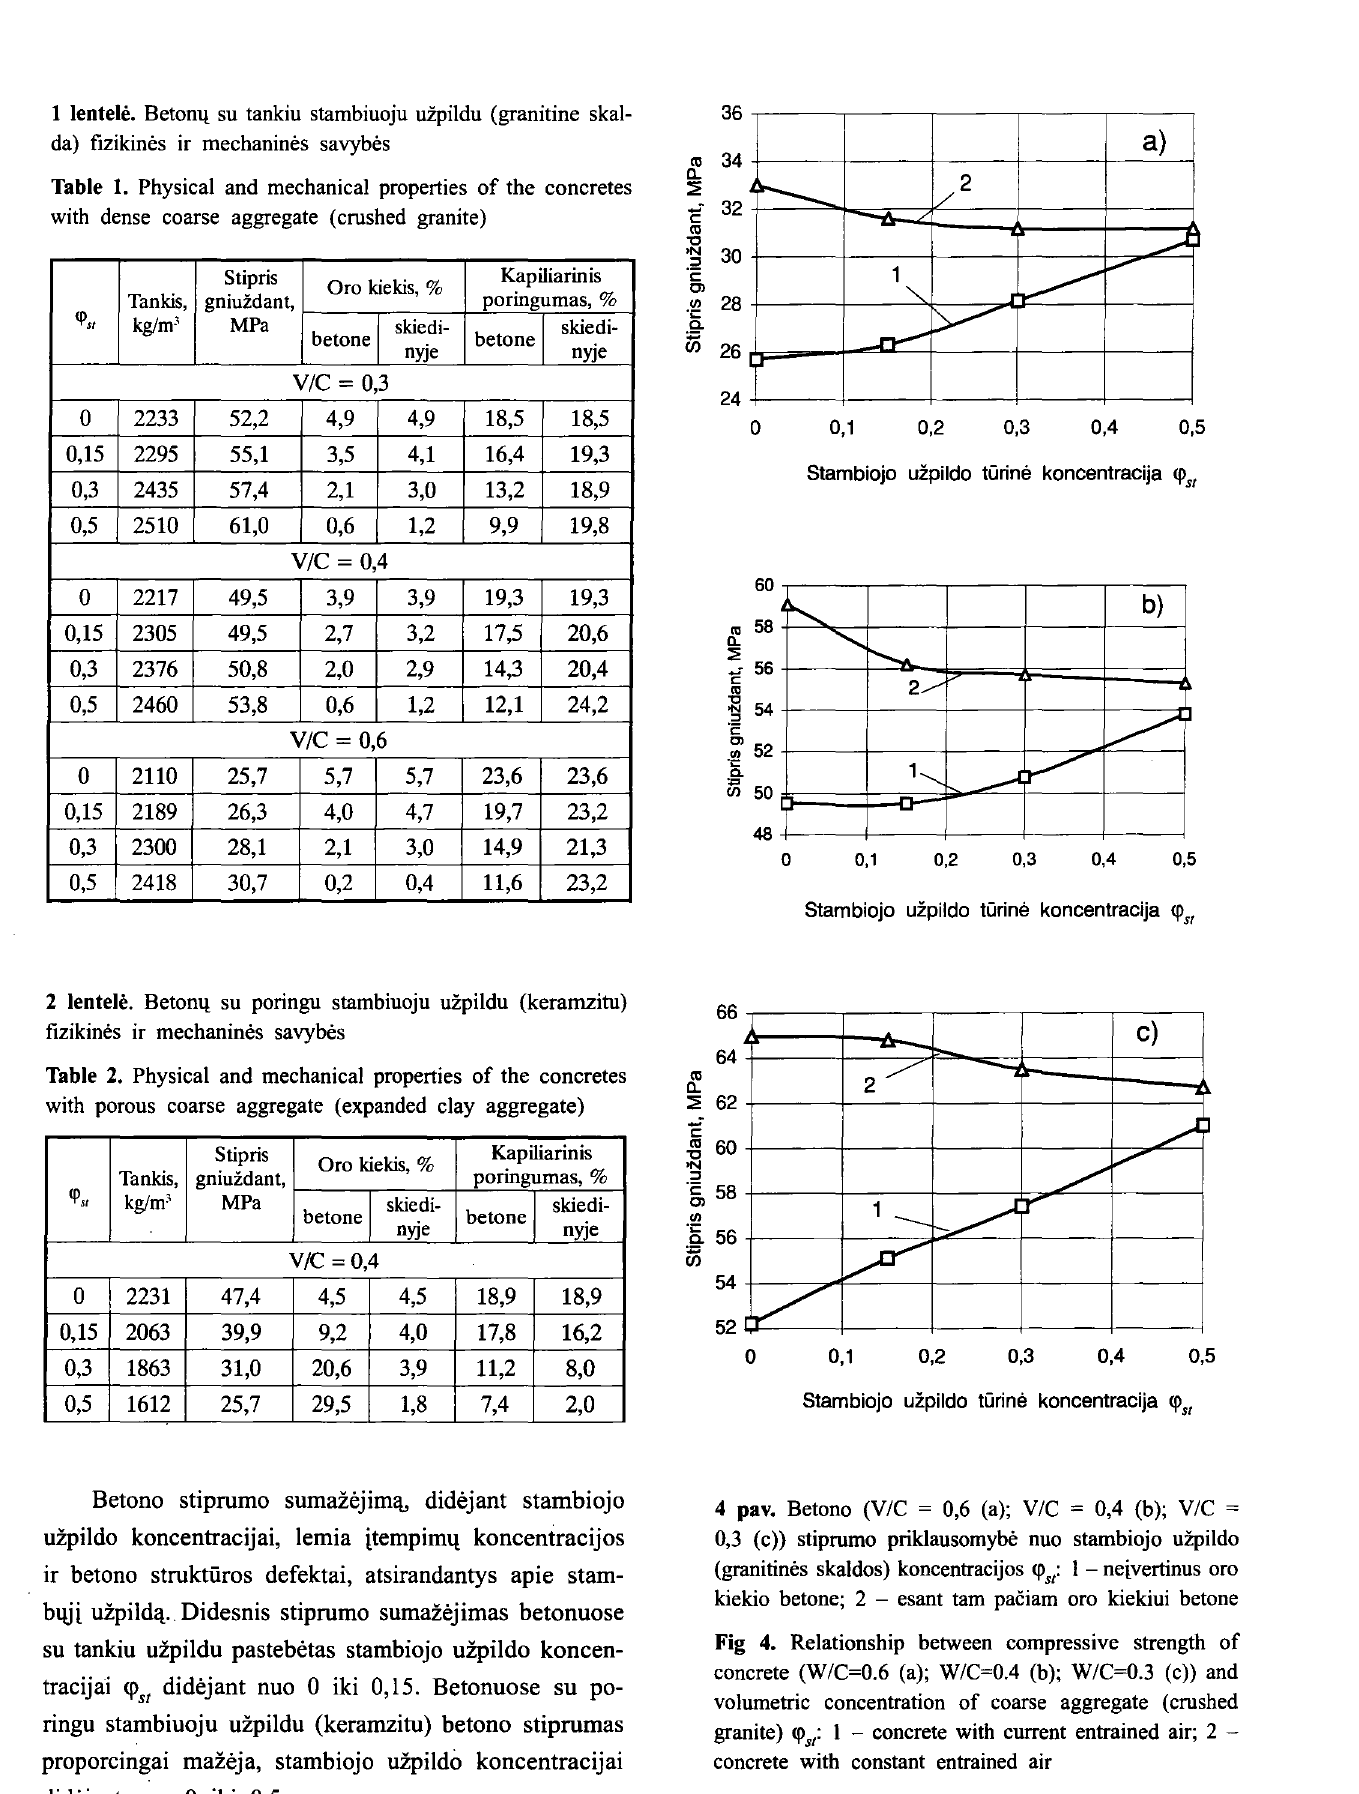
Betono stiprumo sumazejim!!, didejant stambiojo uzpildo koncentracijai, lemia itempimq koncentracijos ir betono struktiiros defektai, atsirandantys apie stam bqji uzpildlt. Didesnis stiprumo sumazejimas betonuose SU tankiu uzpildu pastebetas Stambiojo UZpildo koncen tracijai <p didejant nuo 0 iki 0,15. Betonuose su po 51 ringu stambiuoju uzpildu (keramzitu) betono stiprumas proporcingai mazeja, stambiojo UZpildo koncentracijai didejant nuo 0 iki 0,5.